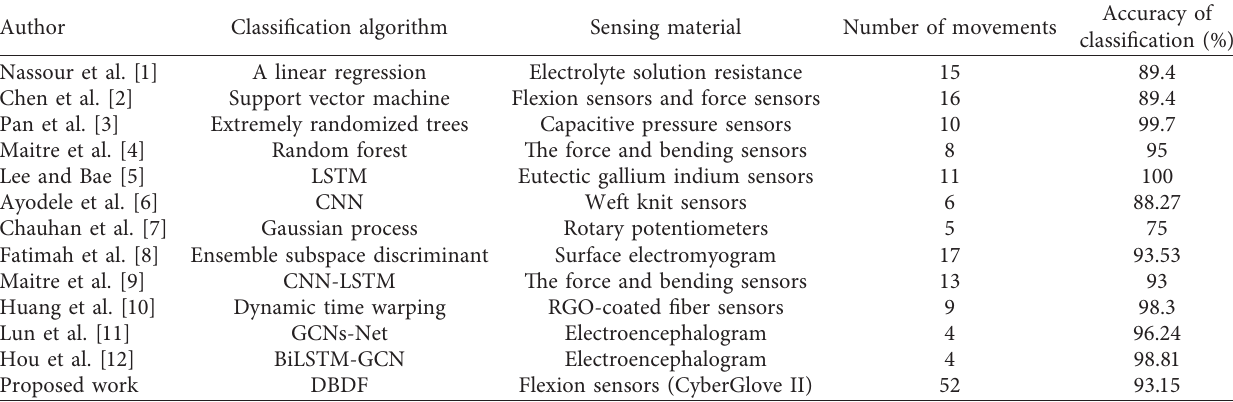
Table 4: Comparison of the number of movements and classification accuracy of the proposed method with existing algorithms.